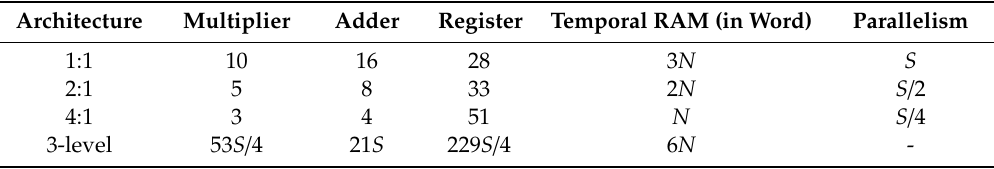
Table 1. Hardware consumption of 3-level 2-D DWT architecture for 9 / 7 filter with N × N image size.